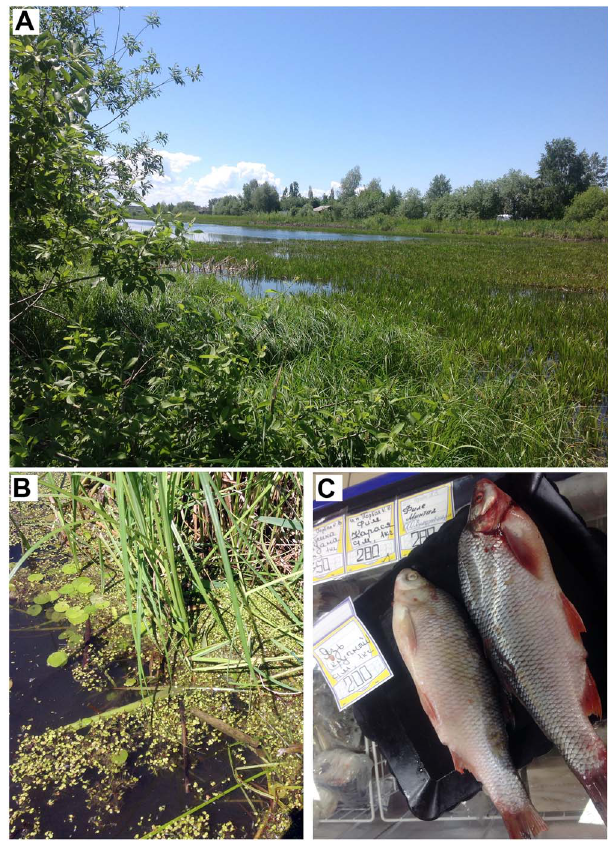
Figure 2. The Maloe lake tributary of the Ob River (Novosi- birsk city) and intermediate host for the liver fl uke Opisthorchis felineus . (A) Maloe lake. (B) Backwater of Maloe lake, a habitat of Bithynia snails. (C) Fresh ides ( L. idus ) on ice at a